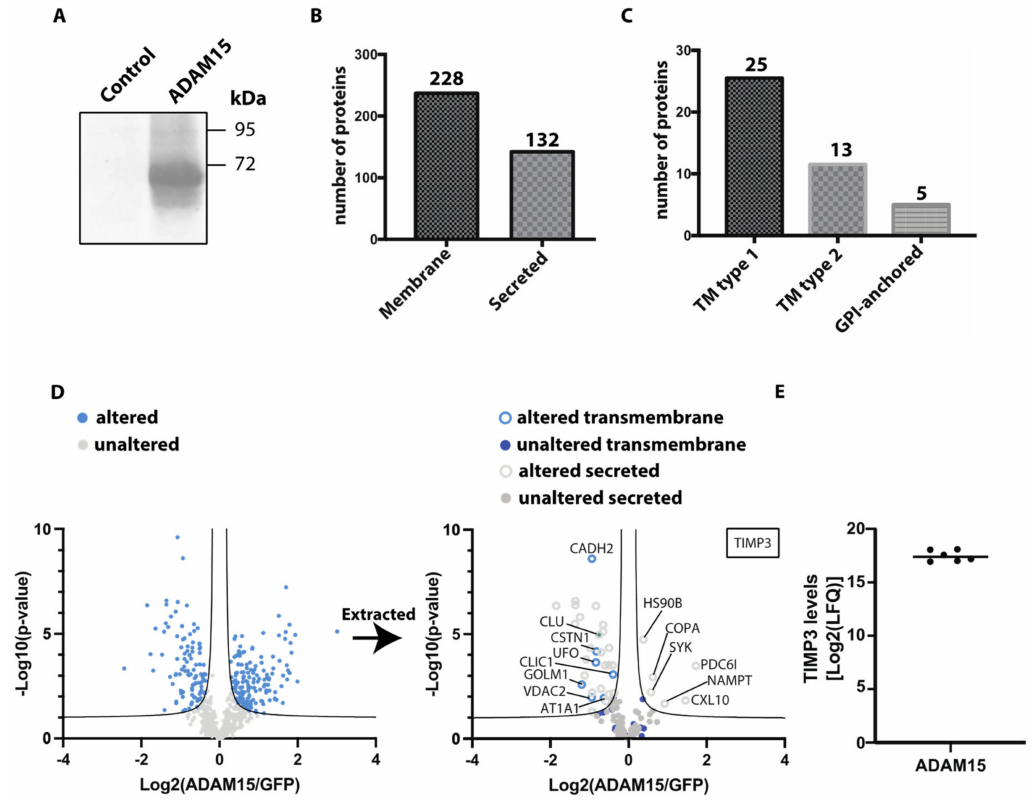
Figure 2. Secretome analysis of ADAM15-overexpressing HTB84 cells. ( A ) HTB94 cells were tran- siently transfected with ADAM15 or GFP as a control, and expression was evaluated by immunoblot- ting. ( B ) Number of proteins annotated as a membrane or secreted proteins detected in the secretome of ADAM15-overexpressing cells. ( C ) Topology of single-span membrane proteins detected in